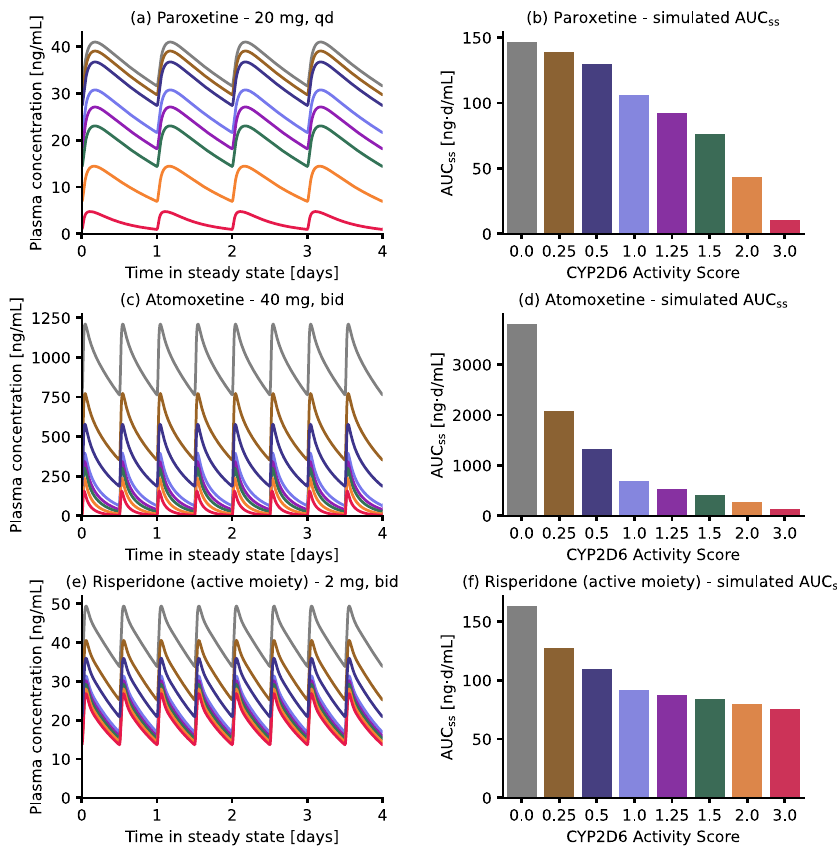
Figure 7. Model-based CYP2D6 DGI predictions. Left panel : simulations of drug exposure in indi- viduals with different CYP2D6 activity scores after multiple oral doses of 40 mg paroxetine once daily ( a ), 40 mg atomoxetine twice daily ( c ) or 2 mg risperidone twice daily ( e ). Right panel: comparison of the corresponding AUC ss values for the different activity scores for paroxetine ( b ), atomoxetine ( d ) and risperidone active moiety (( f ) risperidone and 9-hydroxyrisperidone concentrations). AUC ss : area under the plasma concentration – time curve during steady state (calculated for days 24 – 28), bid: twice daily, and qd: once daily.